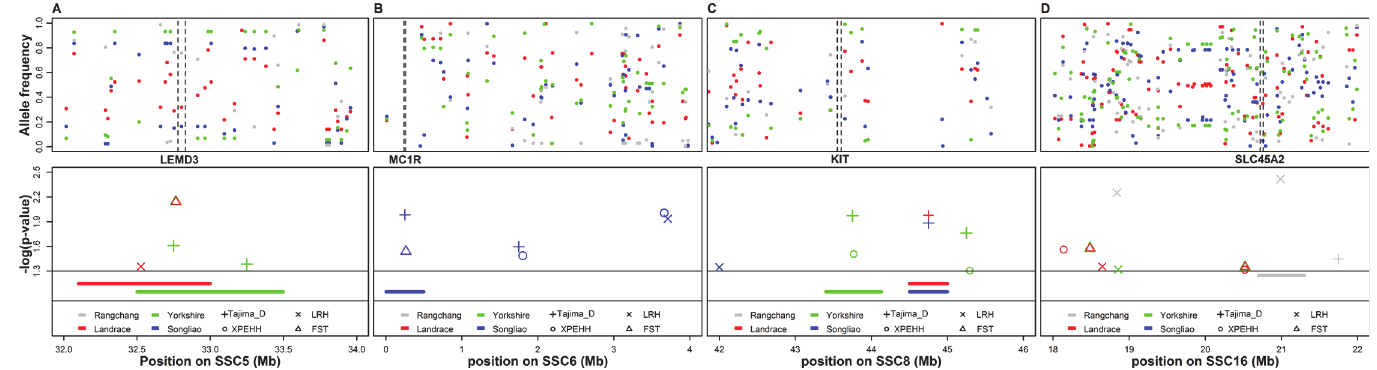
Figure 4. Patterns of genetic variation associated with LEMD3, MC1R, KIT and SLC45A2 genes. Variation in breed allele frequencies of SNPs at the potential selection region for ear morphology/coat color on SSC5, SSC6, SSC8 and SSC16 (color coded by the pig breeds to which they belong), Genomic distribution of potential selection region as measured by four methods, each symbol represents a candidate selection region identified by corresponding methods.